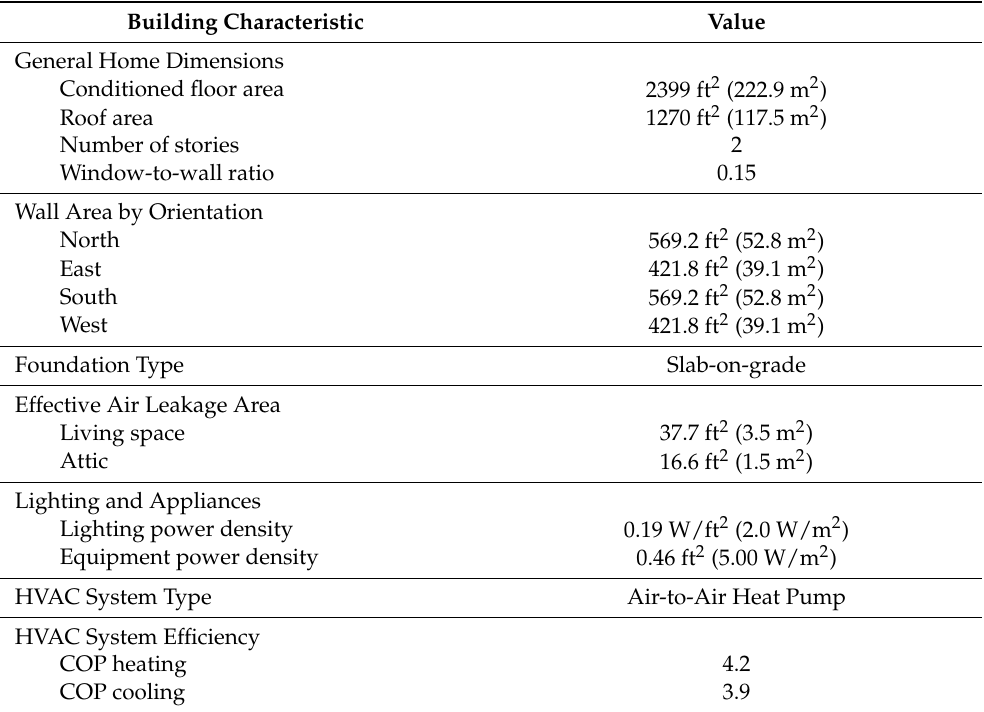
Table 1. Basic features of the detached home model used for the simulation analysis.